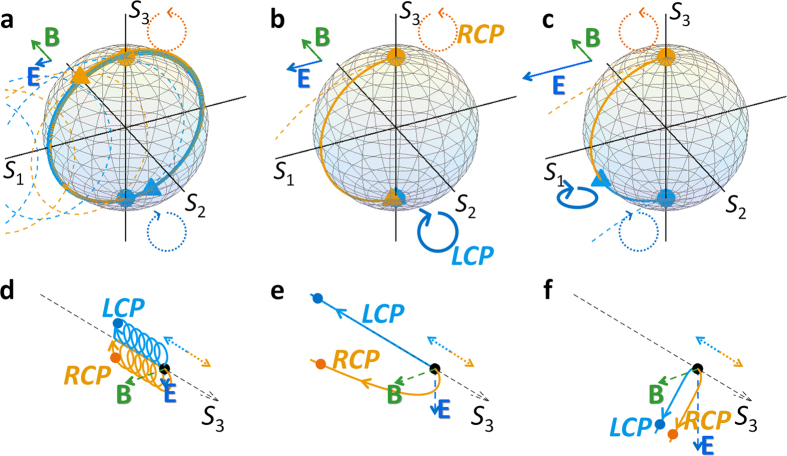
Evolutions of optical SOP in PT-symmetric potentials.(a–c) The change of the SOP at different phases of PT symmetry: (a) before the EP with |B| > |E|, (b) at the EP with |B| = |E|, and (c) after the EP with |B| < |E|. The corresponding movements of charged particles by the E×B drift are shown in (d–f), respectively. While circles and triangles each denote the incident and final (after 10εo1/2·λo/π) state, orange color is for the initial RCP (or positive spin, Sn = e3), and blue color is for the initial LCP (or negative spin, Sn = −e3). The dotted lines in (a–c) represent the non-relativistic movements of the SOP, without the third term in Eq. (2). The dotted arrows for the LCP and RCP in (d–f) denote the initial movement of each spin.